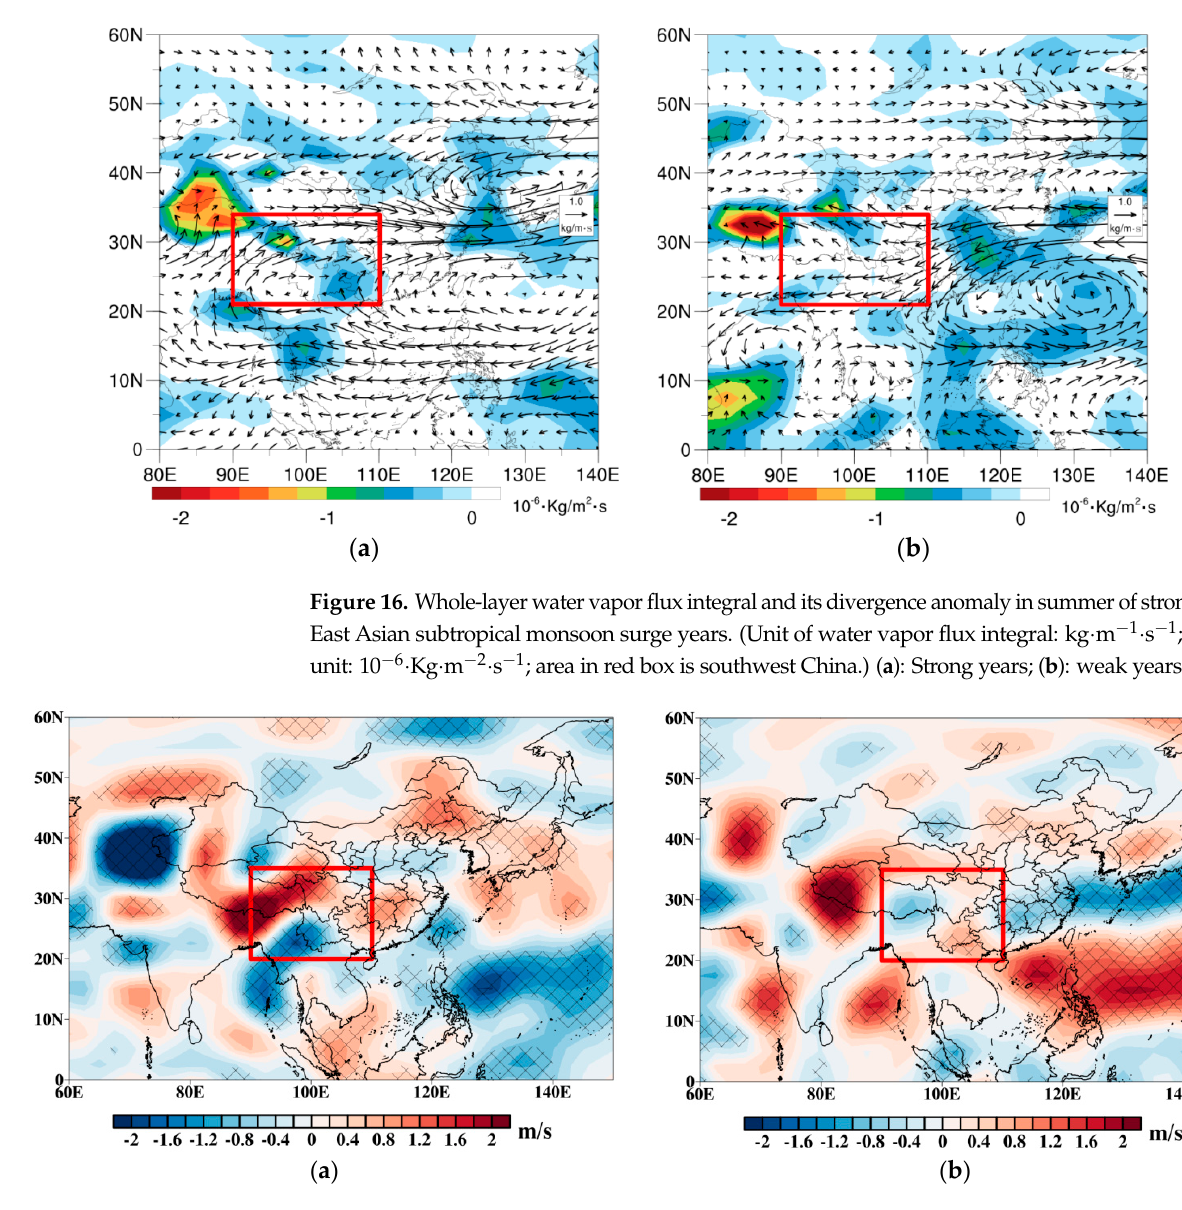
Figure 17. Anomalies of 700 hPa resultant vertical speed in summer of strong and weak East Asian